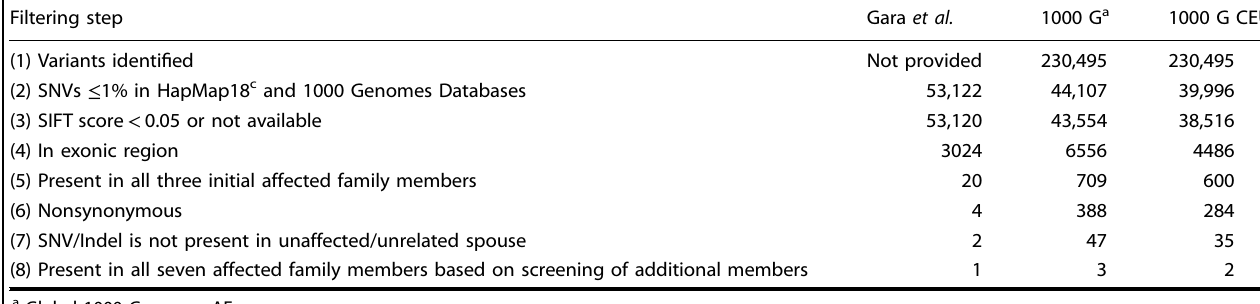
Table 2. Re-analysis of Gara et al. exome data Filtering